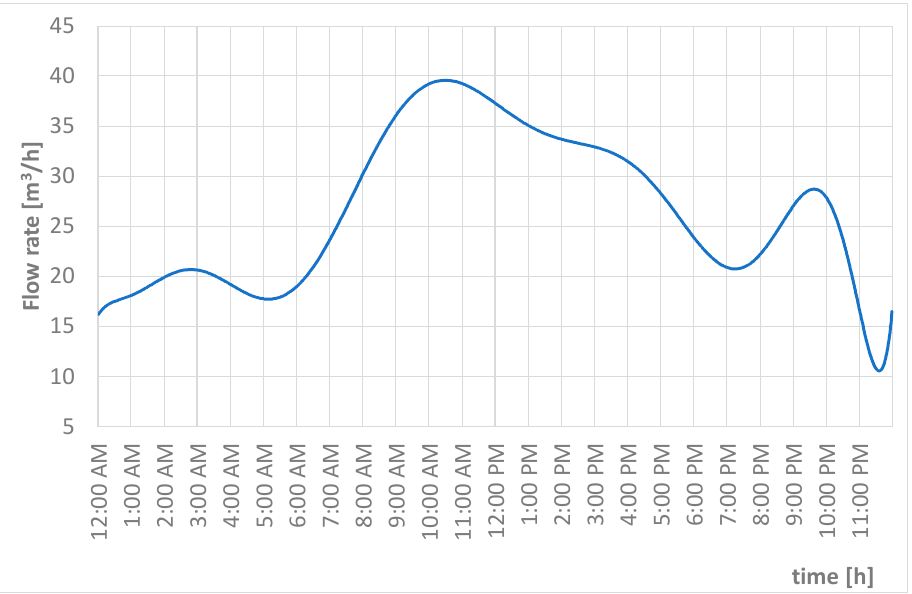
Figure 2. Flow rate versus time for the case study considered.